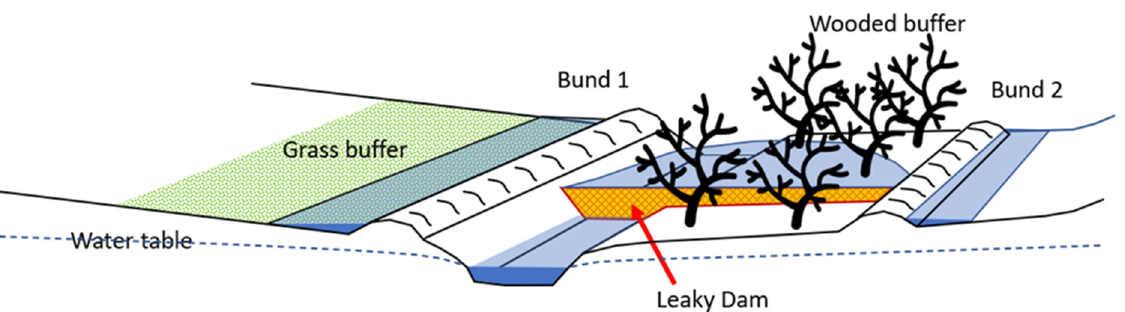
Figure 7. An example of ‘3D buffers’ or ‘Smart Buffers showing both passive and active interventions across the ditch/stream and riparian area, inspired by the 3D buffers project [51]. The choice of vegetation and the positioning of bunds and leaky dams can greatly increase the effectiveness.